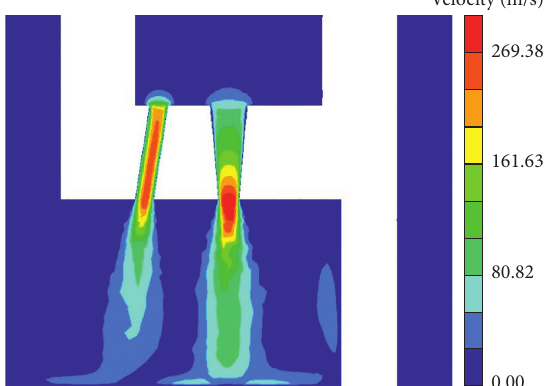
Figure 5: Forward jet velocity cloud diagram of the jet bit.